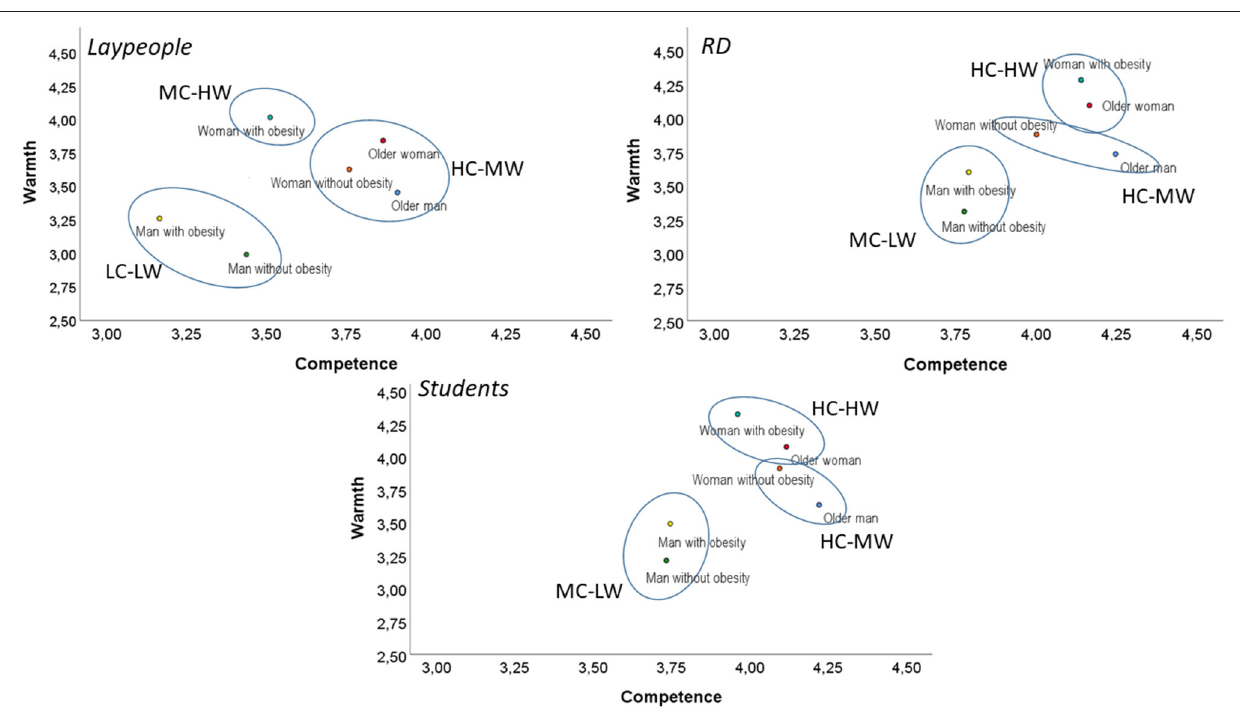
FIGURE 3 | The Stereotype Content Model (SCM) map of dietitians stereotypes. *MC-HW, Middle Competence-High Warmth; HC-MW, High Competence-Middle Warmth; LC-LW, Low Competence-Low Warmth; HC-HW, High Competence-High Warmth; MC-MW, Middle Competence-Middle Warmth; MC-LW, Middle Competence-Low